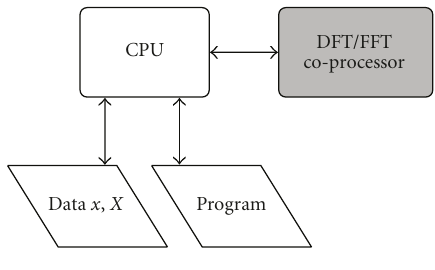
Figure 6: Co-processor configuration of FFT